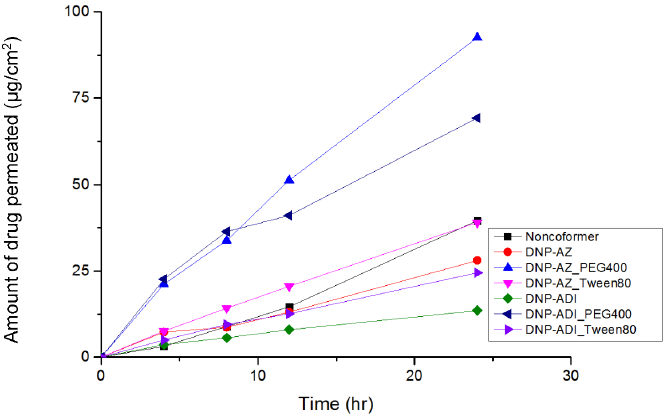
Figure 8. Ex vivo skin permeability of DURO-TAK ® 87-2051 DPZ IL patch formulations (mean, n = 3).